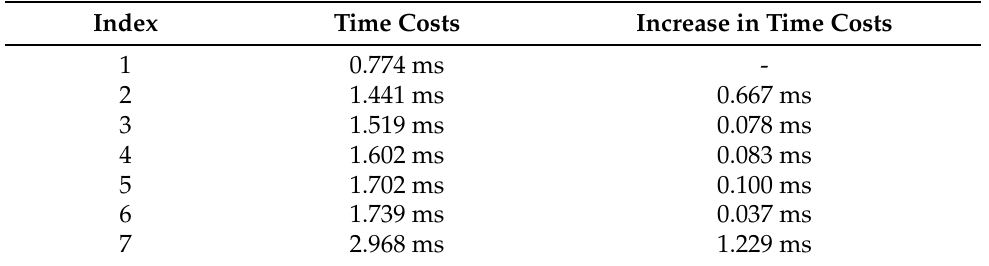
Table 10. Time costs of ablation